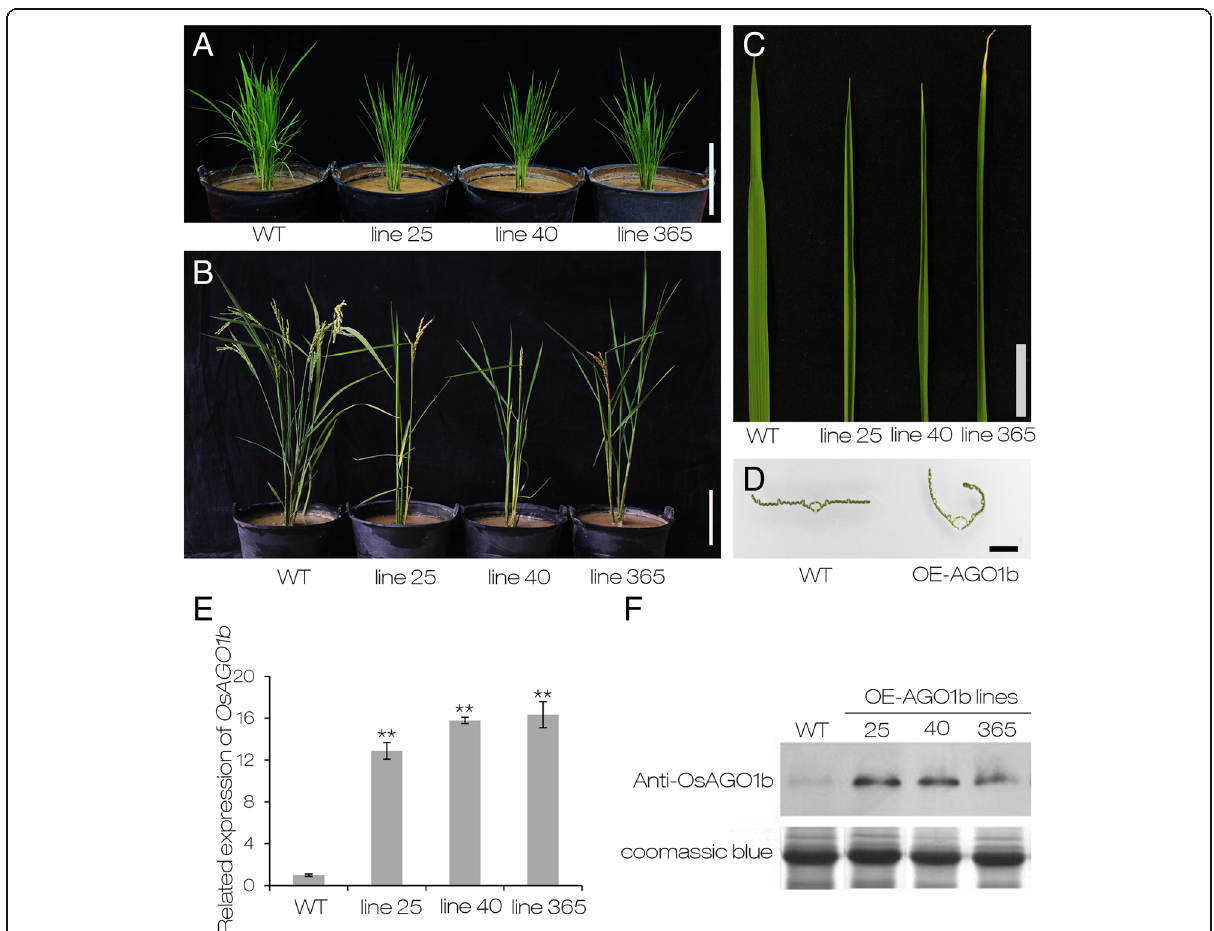
Fig. 1 Morphologies and expression analyses of OsAGO1b overexpression lines. a Morphologies of 30-day-old seedlings of wild type Zhonghua 11 (WT) and OsAGO1b overexpression (OE- AGO1b ) lines (line 25, line 40, line 365). Scale bar = 20 cm. b Plant morphologies of WT and OE- AGO1b lines at the yellow mature stage. Scale bar = 15 cm. c Leaves of 30-day-old seedlings of the WT and OE- AGO1b lines. Scale bar = 2 cm. d Free-hand cross sections of WT and OE- AGO1b leaves from 30-day-old seedlings. Scale bar=1mm. e Relative expression of OsAGO1b in WT and OE- AGO1b lines based on qRT-PCR. Error bars represent standard deviations among replicates. The OsActin1 (XM_015774830) was used as an internal standard to normalize the expression levels of detected genes. f Western blot analysis of the OsAGO1b protein in WT and OE- AGO1b plants. Coomassic blue staining was used as a loading control. Expanded leaves at the heading stage were used for RNA and protein extraction for ( e ) and ( f ). ** P <0.01 (one-way